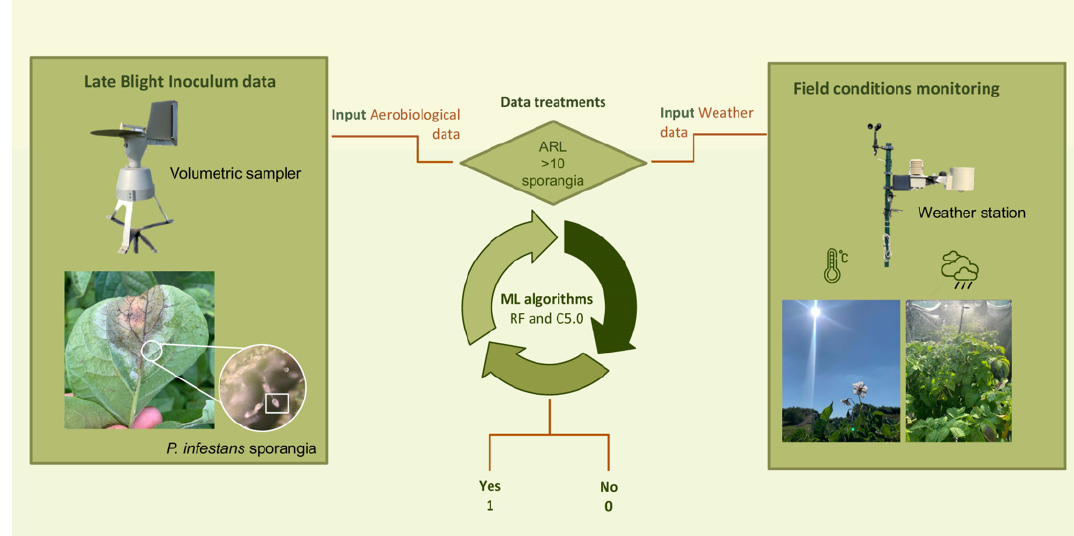
Figure 1. Visual abstract about the inputs (weather and aerobiological variables) used in the machine learning (ML) algorithms. ARL: daily aerobiological risk